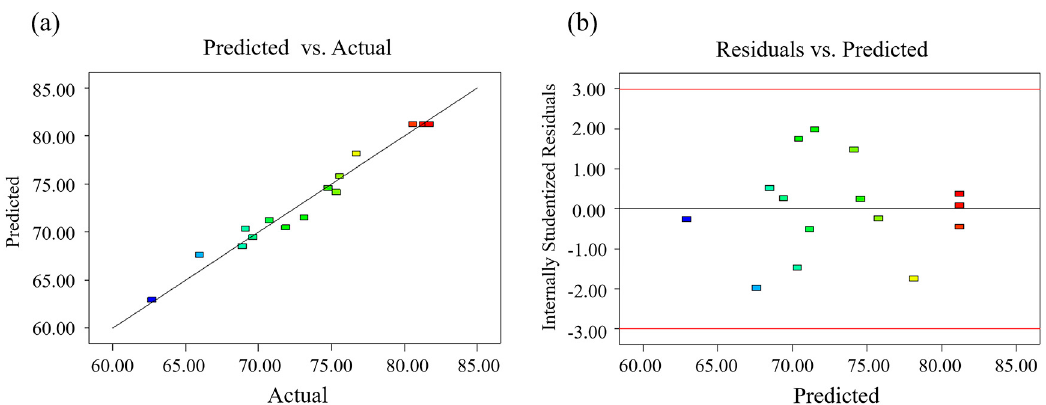
Figure 3. Obtained response of predicted and actual values ( a ), and the relationship between internally studentized residuals and predicted recoveries ( b ).